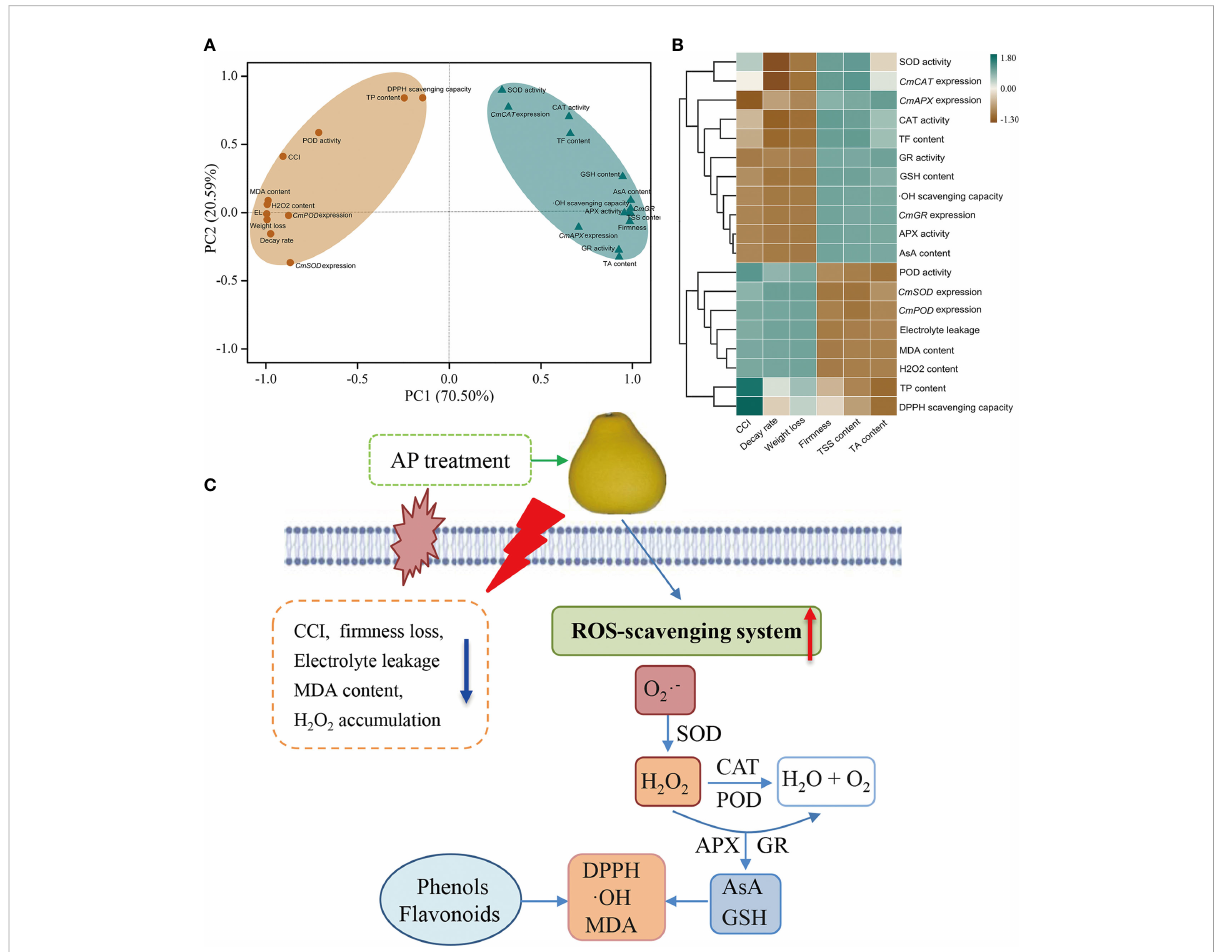
FIGURE 5 The PCA (A) and correlation analysis (B) of the ROS metabolism-related parameters in ‘ Jinshayou ’ pummelo fruit stored at 20°C for 90 d. A proposed model of the potential mechanism of pre-storage AP treatment delayed postharvest senescence and quality deterioration by regulating ROS-scavenging system in harvested ‘ Jinshayou ’ pummelo fruit (C)